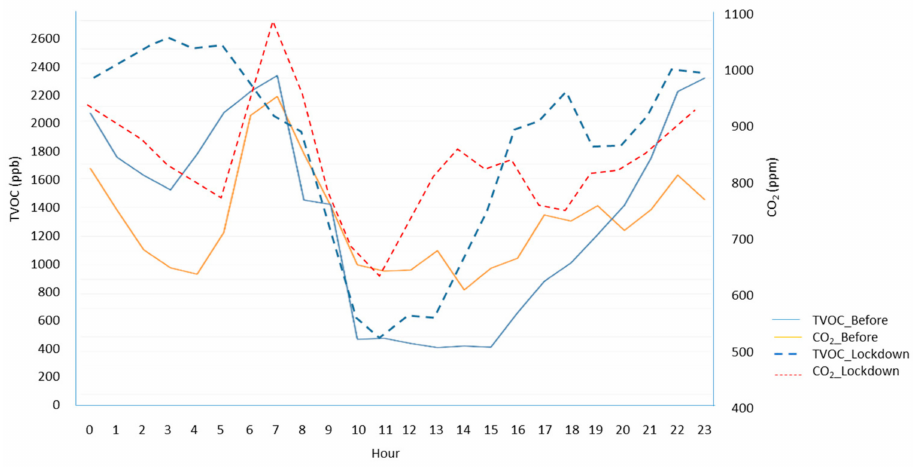
Figure 16. Hourly median profile of TVOC (ppb) and CO 2 (ppm) for CS1. Figure 17 shows the process to which the dwellings were subjected during the lockdown.